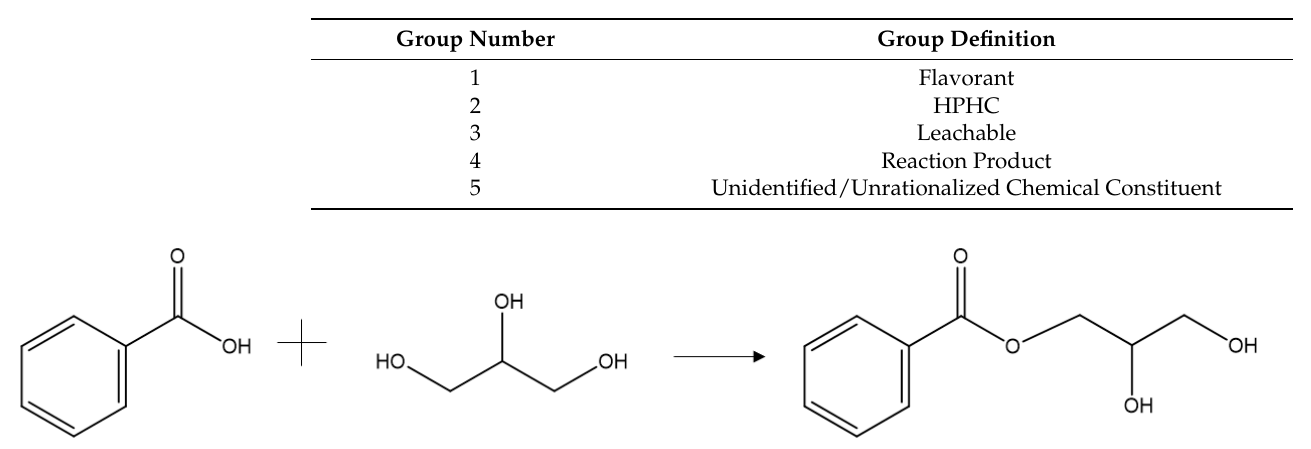
Table 1. Classification of chemical constituent origin identification.